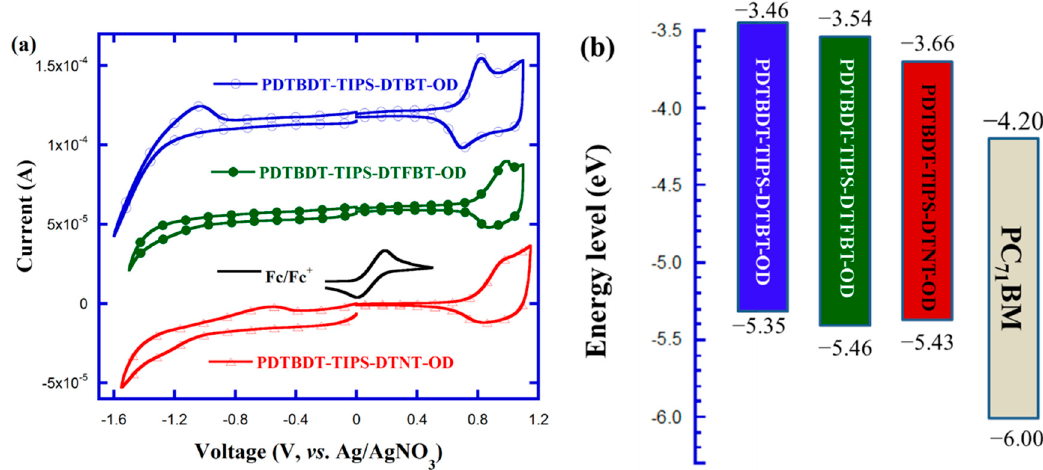
Figure 5. Cyclic voltammetry curves ( a ) and energy levels schematic diagram ( b ) of copolymers.